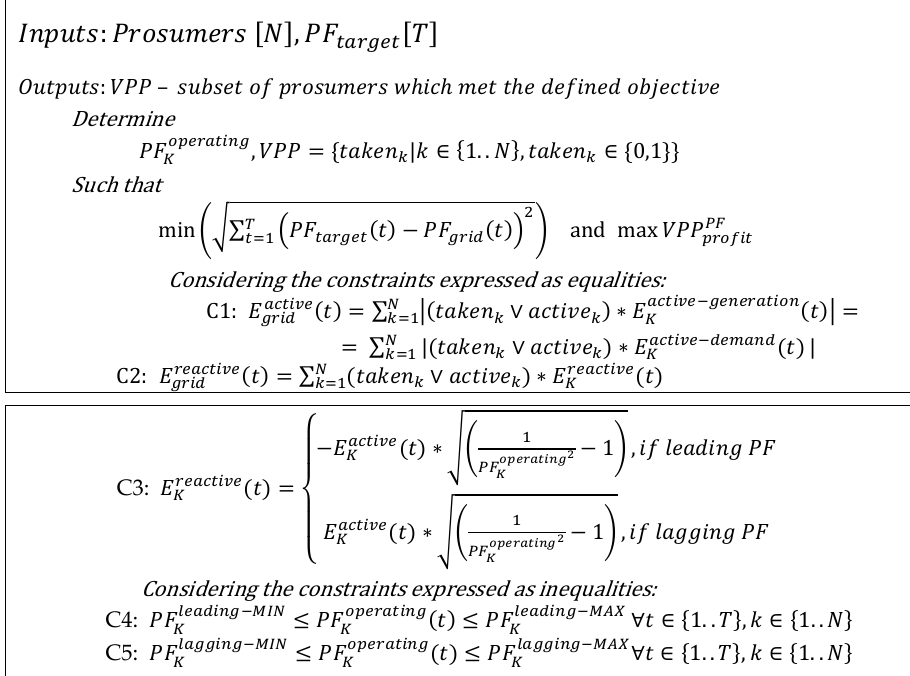
Figure 3. Optimal VPP construction for offering frequency restoration reserve service.